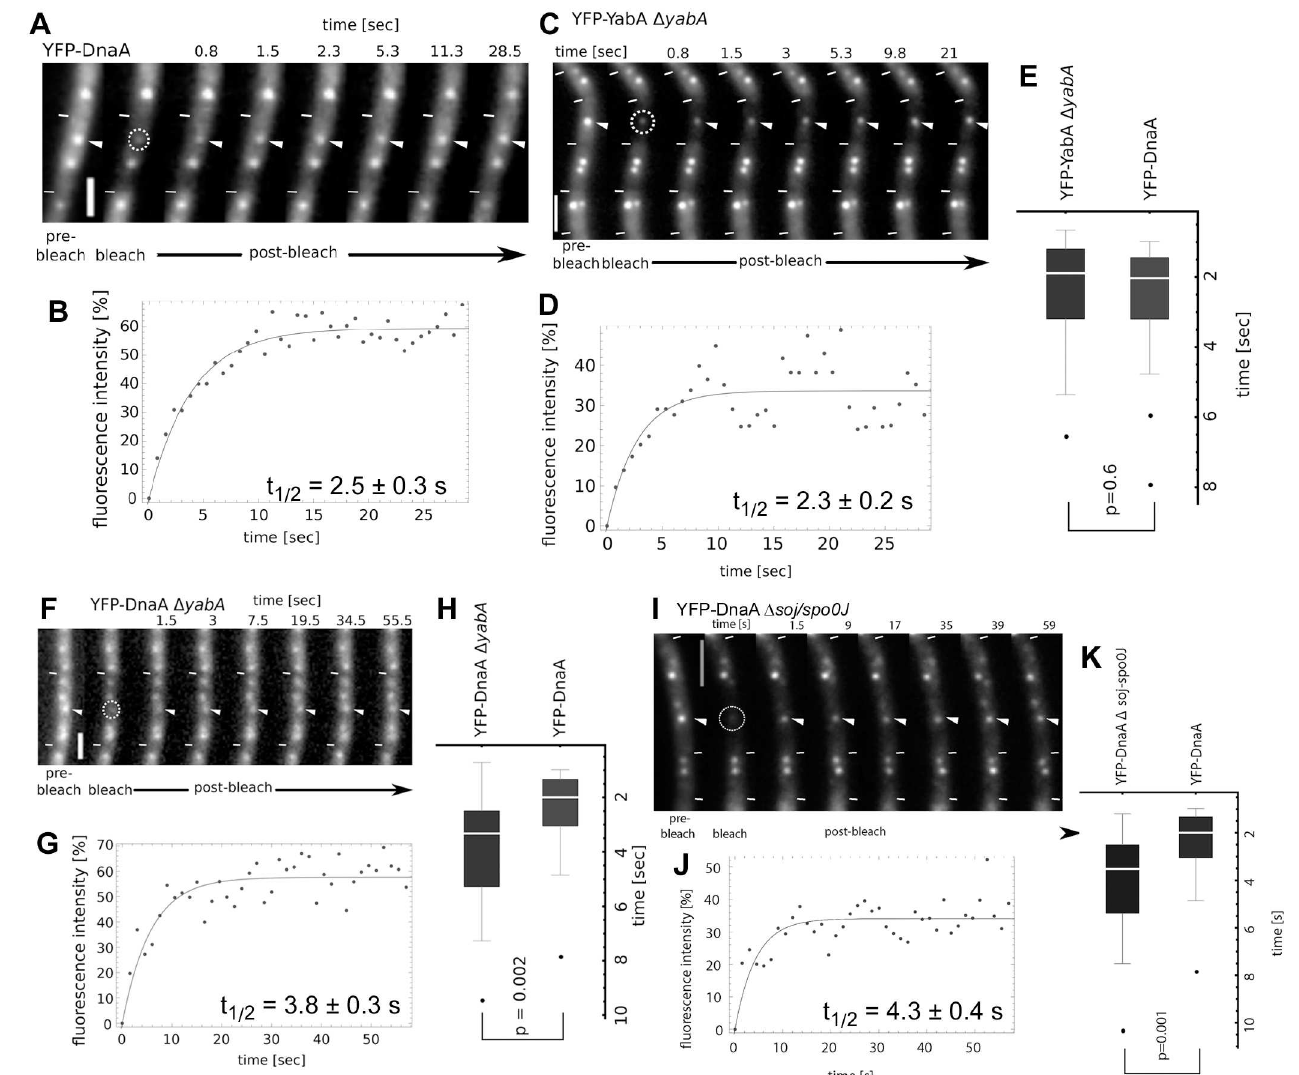
Fig 2. FRAP analysis of exponentially growing cells. A) FRAP sequenceof cells expressingYFP-DnaA as sole source of the protein (strain PG1037). Recovery of the fluorescence signal in the regionof interest (dashedcircle) over time is indicatedby the white triangle. White lines, cell borders, scale bar 2 μ m. B) Fluorescence intensity (%) plotted over time (s). The line represents the fit used to calculaterecovery half-time. Diagramdisplaysdata obtainedfrom a single experiment shown in (A). Calculatedrecovery half-time for YFP-DnaA determinedfrom 32 experiments is 2.5 ± 0.3 s. C) FRAP sequenceof YFP-YabA expressedin a yabA deletionstrain (KS173), similar to panel A). D) Fluorescence intensity (%) plotted over time (s), similar to panel B), determined from 41 experiments. E) Box-plot showingthe distribution of calculatedrecovery half-times for YFP-DnaA (PG1037) and YFP-YabA (KS173). Black dots are considered outliers (lie outsideof 1.5 ITR). YFP-YabA and YFP-DnaA displayeda similar dynamic behavior (students t-test, p = 0.6). F) FRAP sequenceof cells expressingYFP-DnaA in the absenceof YabA (strain KS171), similar to panel A. G) Fluorescence intensity (%) plotted over time (s), for strain KS171 (n = 32), same as panel B. H) Box-plot showingthe distributionof calculatedrecovery half-times for YFP-DnaA (PG1037) and of YFP-DnaA in cells lackingYabA (KS171). I) FRAP sequenceof cells expressingYFP-DnaA in the absenceof Spo0J/Soj (strain KS175), similar to panel A. J) Fluorescence intensity (%) plotted over time (s), for strain KS175 (n = 42), same as panel B. K) Box-plotshowingthe distributionof calculatedrecovery half-times for YFP-DnaA (PG1037) and of YFP-DnaA in cells lackingSpo0J/Soj